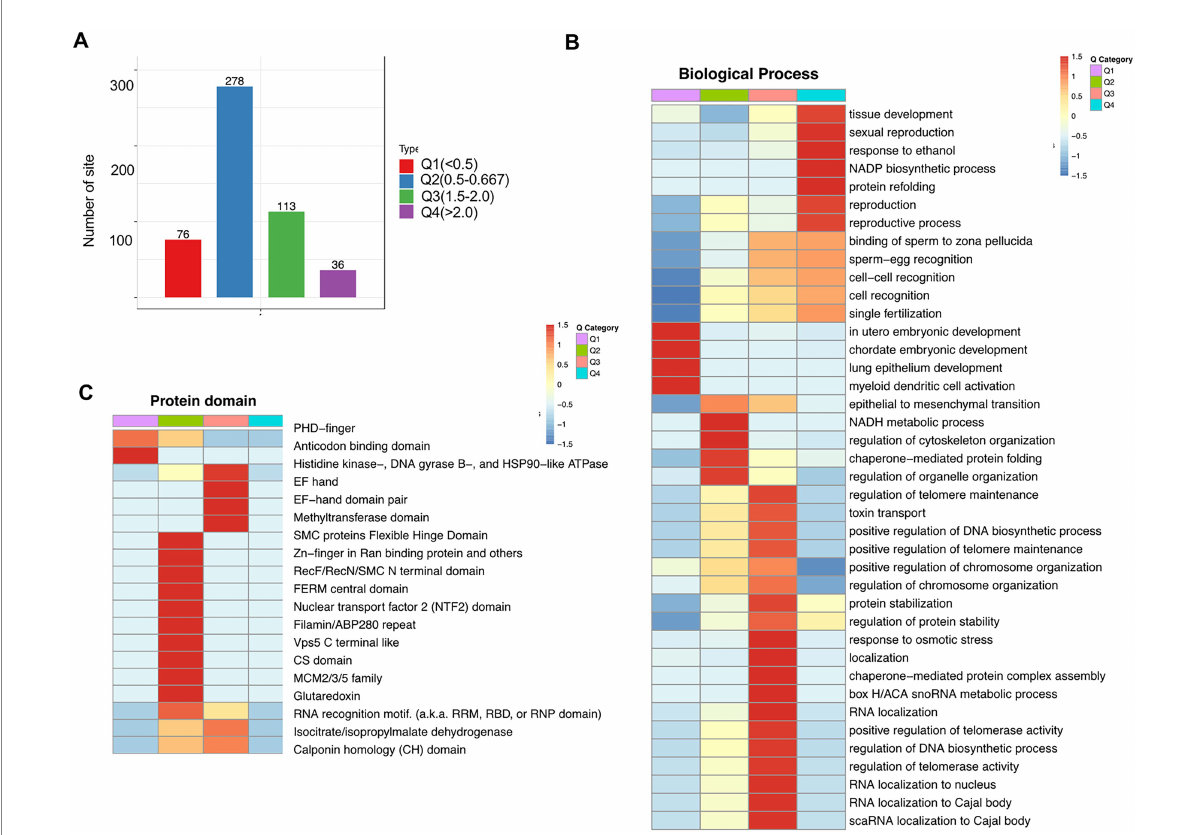
FIGURE 7 Enrichment analysis of cross-talk between lysine crotonylation and biological processes and protein domains in folate-free mESCs. (A) We further divided different Kcr sites into four parts according to the differential expression: Q1 (fold change < 0.5), Q2 (fold change 0.5–0.667), Q3 (fold change 1.5–2.0), and Q4 (fold change > 2). (B) Biology process, (C) and protein domain. Heatmap showing profiles of all quantifiable Kcr sites in Q1–Q4 normalized according to quantitative proteomics analysis under folate deficiency in mESCs. Fischer’s test p values obtained from enrichment analysis were used for hierarchical clustering to combine relevant functions in different Q groups and draw a heatmap. The color block corresponding to the functional description of the enrichment of different Q groups and differentially expressed modified proteins indicated the degree of enrichment. Red represents the enrichment degree; blue indicates the enrichment degree is